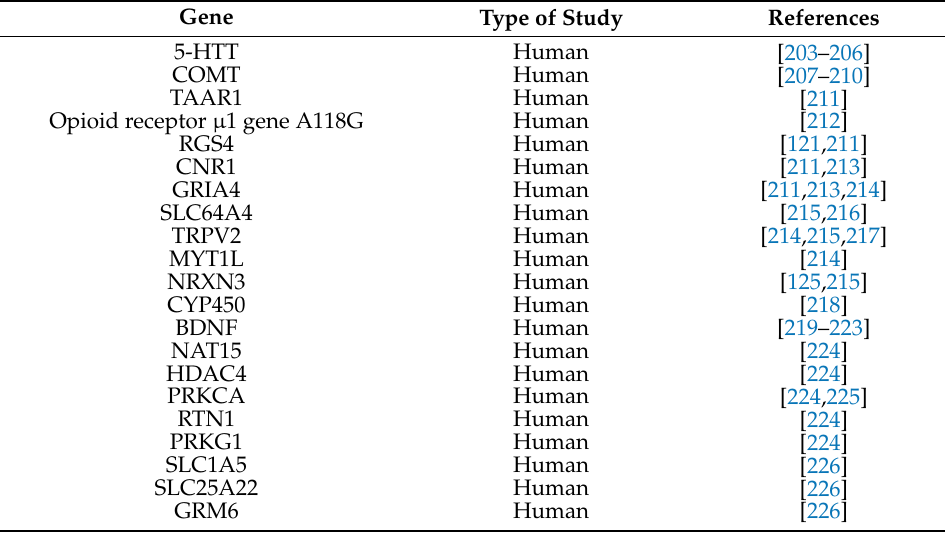
Table 1. Candidate genes in the pathogenesis of FM [202]. Gene Type of